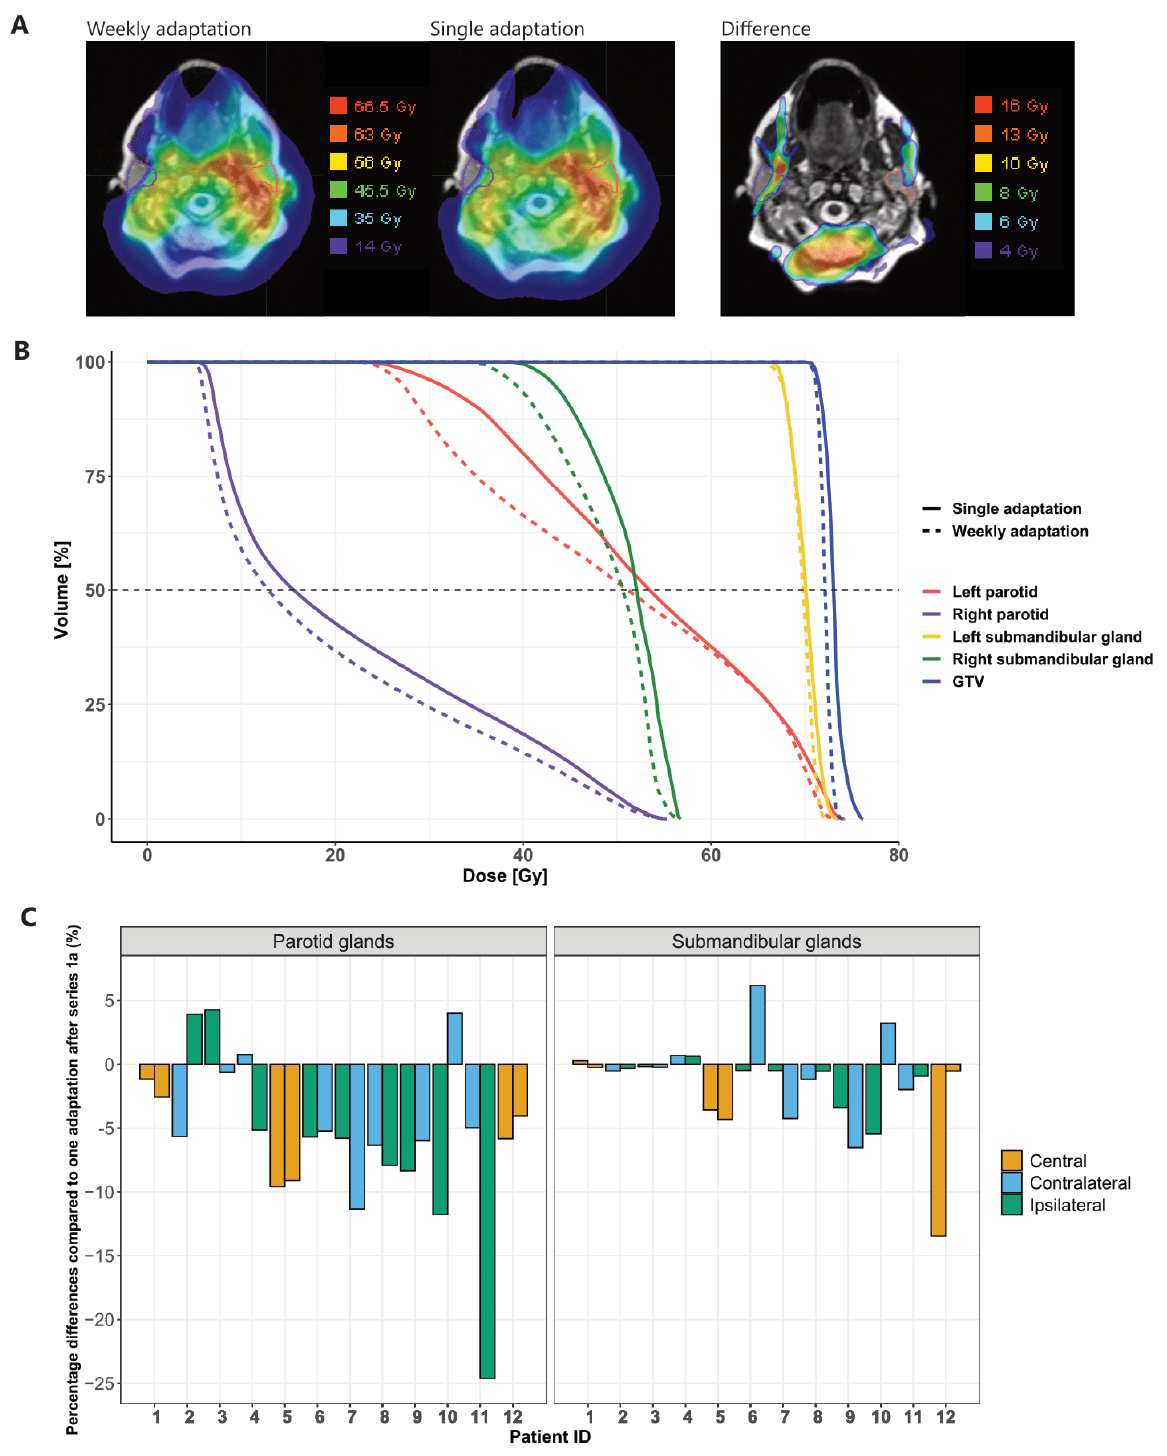
Figure 5. The difference between weekly adaptation and one adaptation at the end of treatment. ( A ) Example of a dose distribution (patient 7) of weekly adaptation (left) or one single adaptation (middle) and the difference between dose distributions (right). ( B ) Corresponding DVHs of the patient in ( A ). ( C ) Dose difference for all the patients for the parotid glands (left) and the submandibular glands (right). Negative values mean that the cumulative planned dose was lower using weekly adaptation. In case of a symmetric bilateral treatment of a centrally located tumor without clear lateraliza-tion, the term “central” was used to indicate the location of the salivary glands.